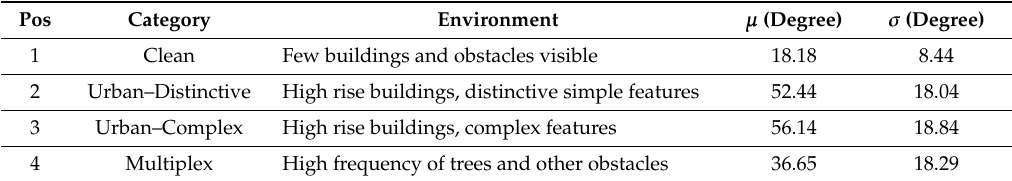
Table 1. Fisheye image categories, and experiment locations.